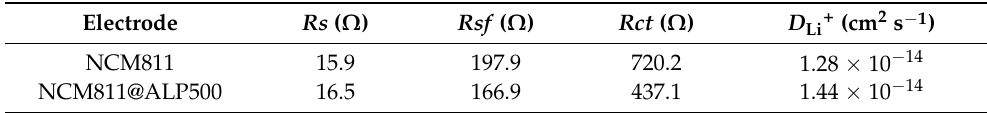
Table 3. The fitted values of Rs , Rsf , and Rct and the calculated values of D Li+ of the pristine